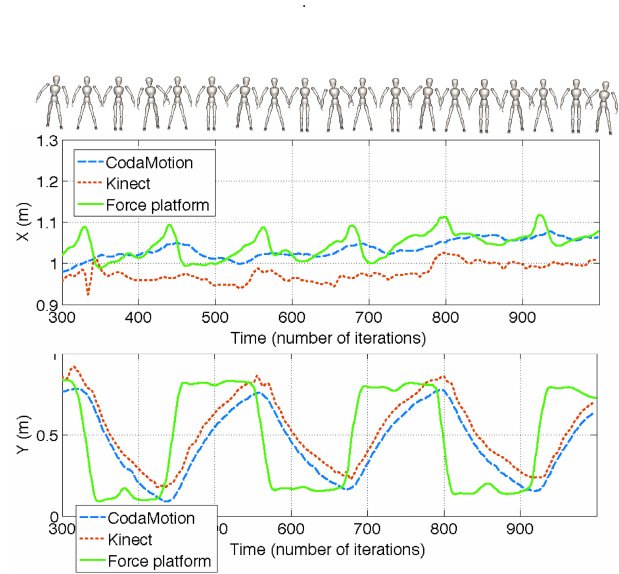
Figure 12. CoP trajectory results of rocking movement for a subject. The tra- jectories issued from Kinect and CodaMotion data are calculated by Arboris. .